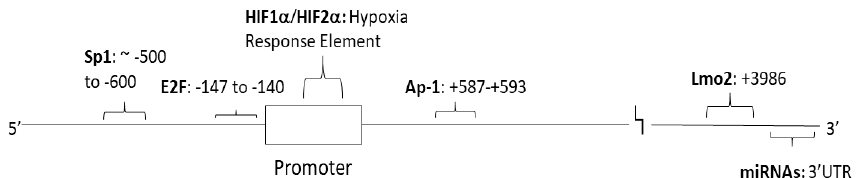
Figure 1. Location of transcription factor binding on the SK1 Gene. Approximate locations of SPHK1 transcription factors in relation to the SPHK1 promoter region. Transcription factors have been shown to bind both upstream and downstream of the promoter. E2F is known to be important in regulating SK1 in cancer, while Sp1 is associated with upregulating SK1 in cancer and in response to neuronal growth factors. In hypoxic conditions, HIF2a and Lmo2 were shown to upregulate SK1, especially in cancer models. AP-1 upregulates SK1 in response to the cytokine IL-1b. MicroRNAs (miRNAs) have been shown to bind to certain sequences in the 3’UTR of the SPHK1 transcript.